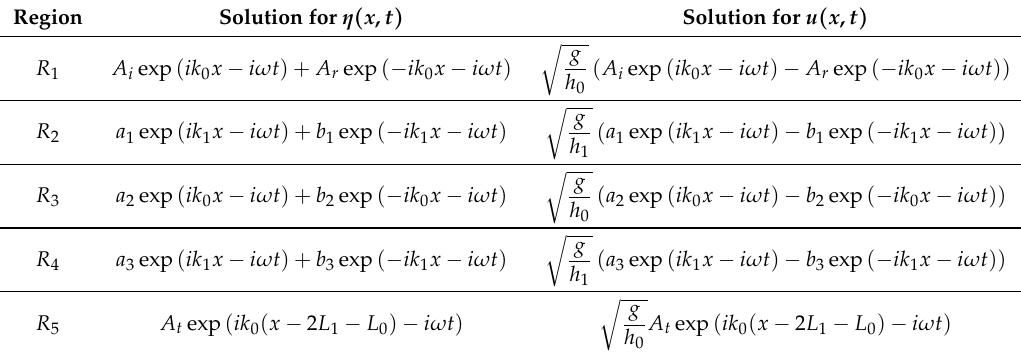
Figure 3. Diagram of a two-bar wave reflector with height ( h 0 − h 1 ) , optimal length L 1 separated by a distance of L 0 . Table 1. Surface elevation η ( x , t ) and water velocity u ( x , t ) of an incident wave. Region Solution for η ( x , t ) Solution for u ( x , t